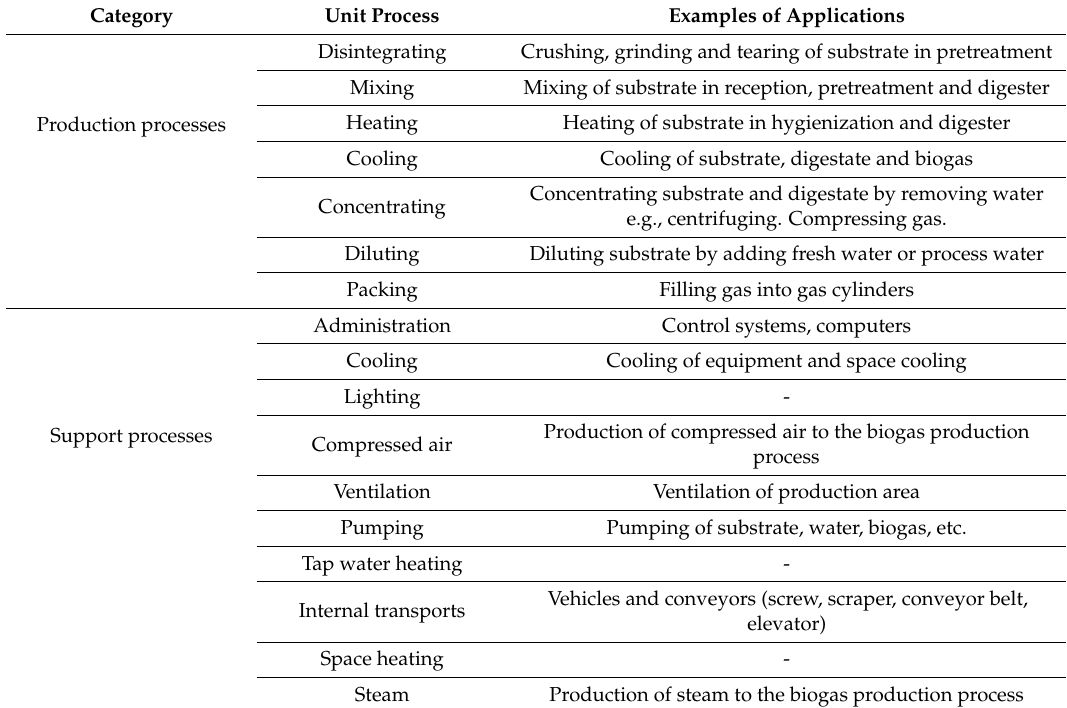
Table 1. Taxonomy of unit processes associated with biogas production (inspired by Rosenqvist et al.